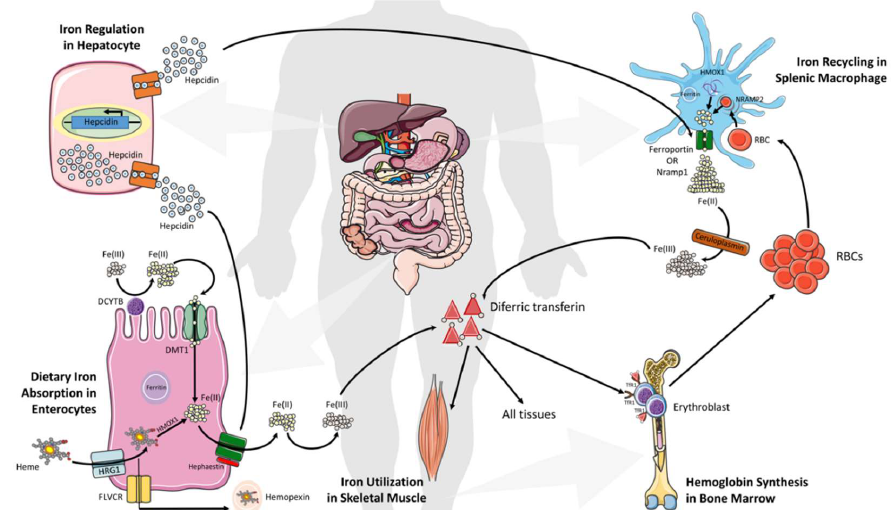
Figure 1. Systemic iron metabolism. Cells and organs involved in iron regulation are shown. Hepcidin produced in hepatocytes regulates iron efflux from other cells by regulating the stability of ferroportin. Hepatocytes sense iron levels and release hepcidin accordingly. Divalent metal transporter 1 (DMT1) on enterocytes internalize iron from the lumen of the duodenum after ferric Fe(III) is reduced to ferrous Fe(II) by ferrireductase. In parallel, free heme is internalized via HRG1 and hemoxygenase-1 (HMOX1) helps to release Fe(II). Ferroportin on the enterocyte’s membrane that cooperates with hephaestin (HEPH) oxidizes Fe(II) to Fe(III). Besides, hepcidin binds to ferroportin on macrophages and duodenal enterocytes and splenic reticuloendothelial macrophages recycle iron from senescent red blood cells and release via ferroportin with the aid of natural resistance-associated macrophage protein 1 (Nramp1). Fe(II) is then oxidized into Fe(III) via ceruplasmin (Cp) in the circulation. Plasma transferrin (Tf) captures and circulates iron in the body, and Tf–Fe 2 supplies iron to all tissues in host body. Hepatocytes sense iron levels in host and release hepcidin, a hepatic hormone that regulates iron efflux from these cells by regulating the stability of ferroportin. The synthesis and secretion of hepcidin by hepatocytes is also influenced by several conditions in the host, including inflammation, endoplasmic reticulum (ER) stress, and hypoxia. Daily absorbed iron (1–3 mg) represents only a fraction of the total body iron, while the recycling of heme from senescent erythrocytes by reticuloendothelial (RE) macrophages provides the main fraction of circulating iron [53]. Ferroportin exports the iron from heme into the circulation, and binds to apotransferrin for hemoglobin synthesis in the bone marrow. However, liver hepatocytes play a critical role in regulating serum iron levels via the integration of information on the systemic iron status, and secreting an appropriate amount of hepcidin that orchestrates systemic iron fluxes and controls plasma iron levels (Figure 1) [4,54]. Hepcidin also influences the internalization of ferroportin, decreasing iron export. An Increased level of hepatic iron (>30 μmol/g of dry weight) and inflammation are positively correlated with hepcidin production, and they are negatively correlated with ferroportin degradation in intestinal cell RE macrophages, which leads to an iron reduction in plasma [55,56]. Mechanistically, iron–transferrin complexes bind to TfR1 on hepatocytes, thereby displacing the TfR1-associated protein, HFE. Then, the binding interaction between HFE and hepatocyte-specific type 2 transferrin receptor (TfR2) transduces signals acting together with other signals from bone morphogenetic proteins (BMPs) to increase hepcidin secretion. This leads the binding of hepcidin to the transporter ferroportin on enterocytes and macrophages to induce its